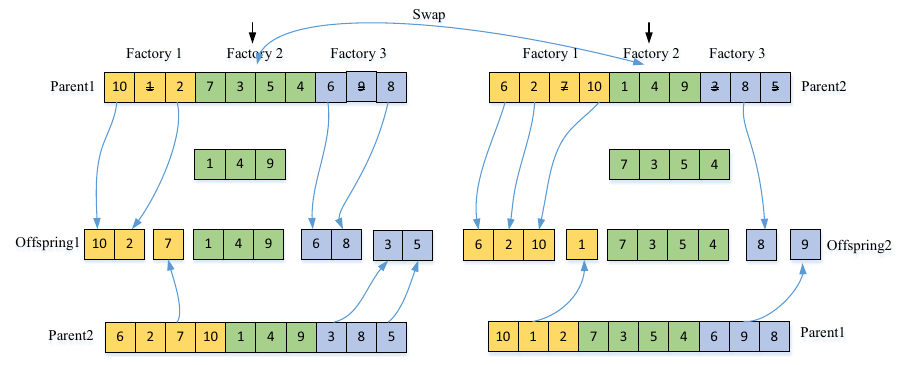
Figure 12. Crossover